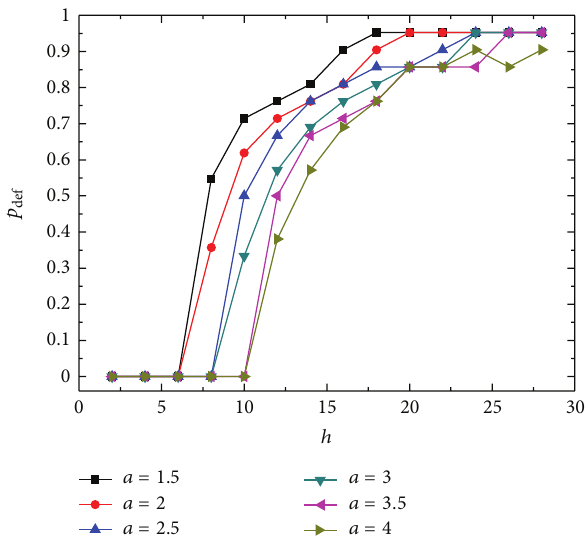
Figure 3: The defects stabilize at the relative position 𝑝 def on the cylinder axis, where 𝑝 def = 0 means the center of the capillary and 𝑝 def = 1 the end of it. Here the position of the defect length of the capillary ℎ at different meniscus curvatures 𝑎 is